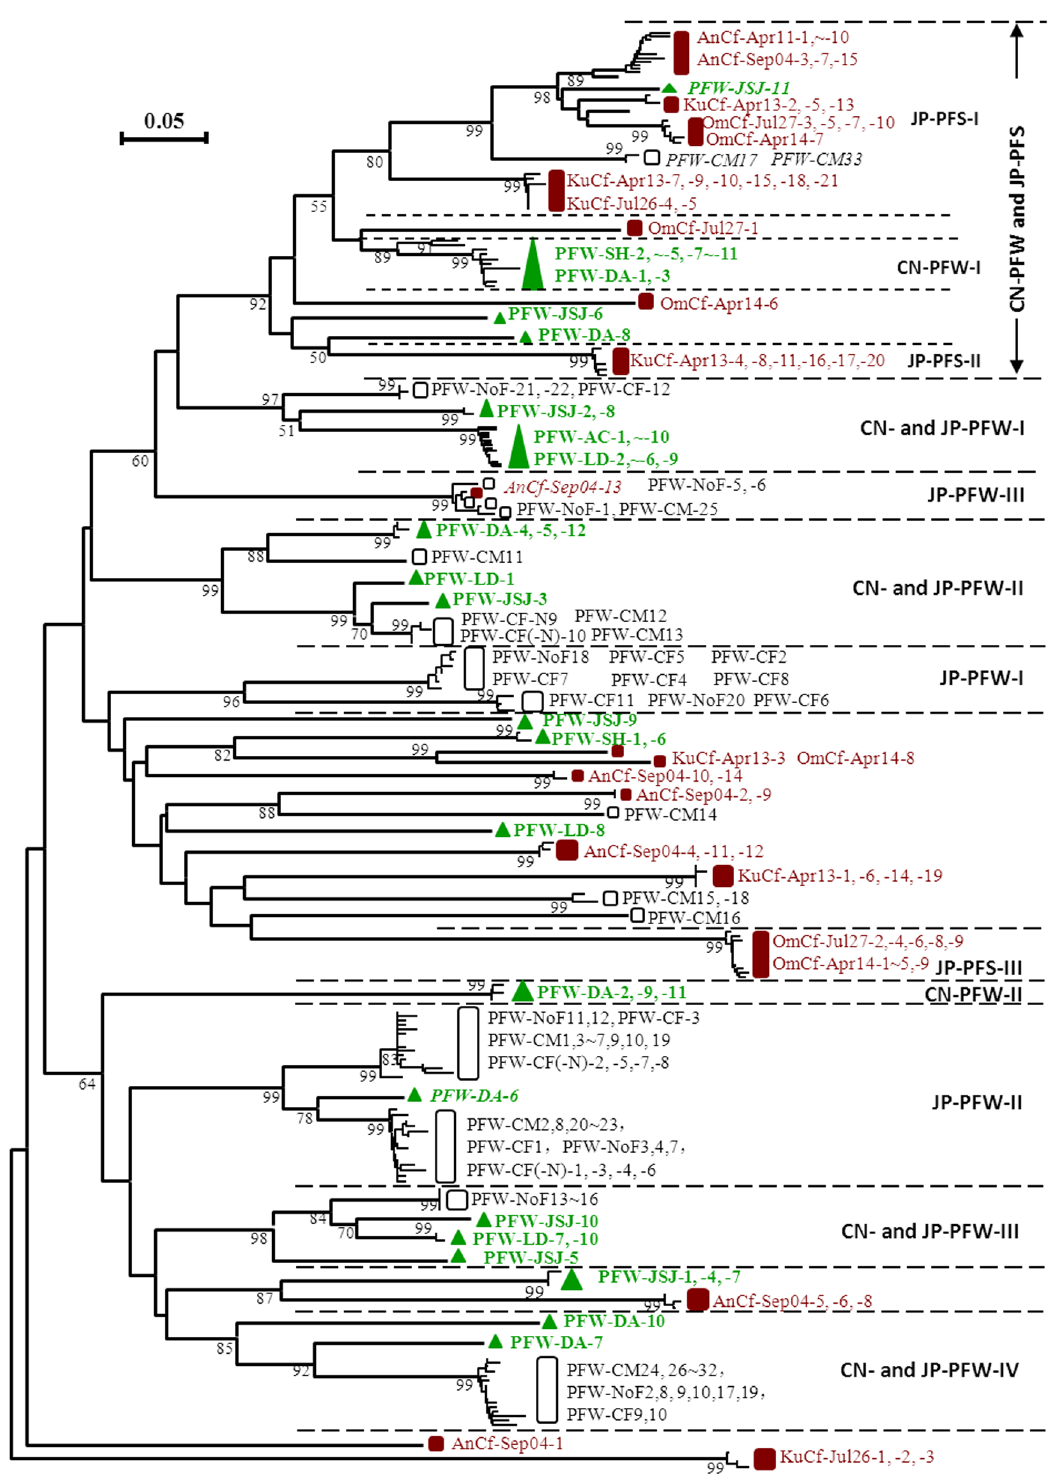
Figure 1. Neighbor-joining phylogenetic tree showing the relationship of g20 amino acid sequences from paddy floodwaters in NE China with those from Japanese paddy floodwaters (Wang et al. 2010) and paddy field soils (Wang et al.2011). Brown and white square boxes indicate g20 clones obtained from paddy field soils in Japan and paddy floodwaters in Japan, respectively; green triangles indicate g20 clones obtained from paddy floodwaters in NE China; JP and CN represent Japan and China, respectively; PFW and PFS represent paddy floodwater and paddy field soil, respectively. Bootstrap values , 50 are not shown. The scale bar represents the number of amino acid substitutions per residue.